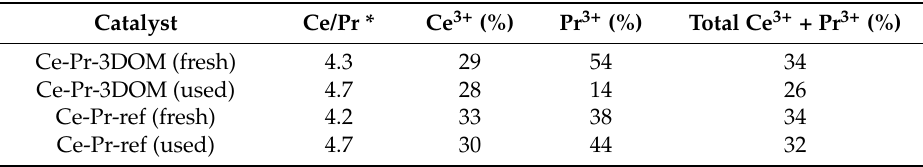
Table 3. XPS characterization of the fresh and used catalysts’ surface.